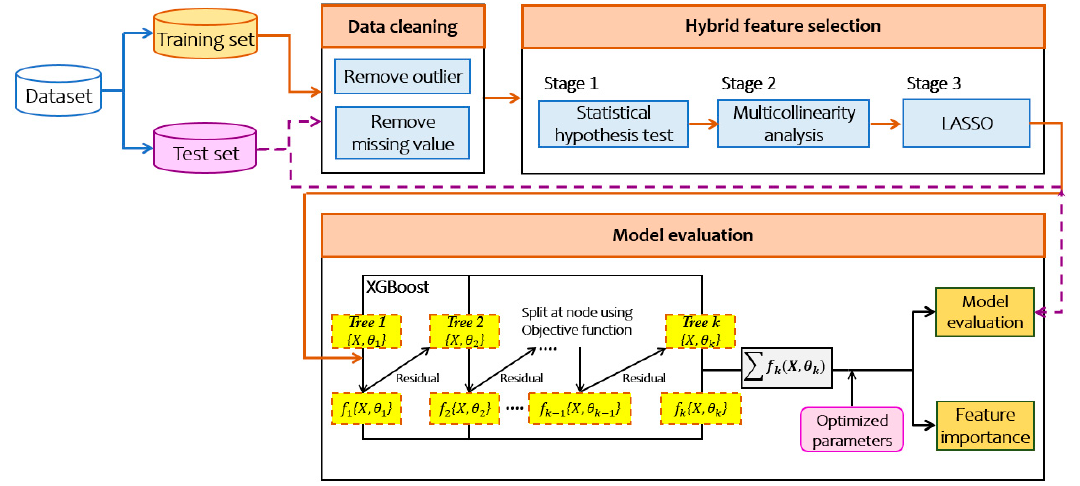
Figure 1. Extreme gradient boosting (XGBoost) based framework for smoking-induced noncommunicable diseases prediction. LASSO: least absolute shrinkage and selection operator.